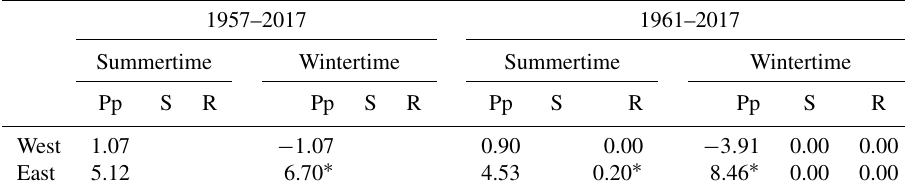
Table 2. Decadal changes in the precipitation percentage (Pp), the number of days with snowfall-driven G-CHs (S) and the number of days with rainfall-driven G-CHs (R). The values with asterisks are significant at 95%; the empty spaces correspond to data not